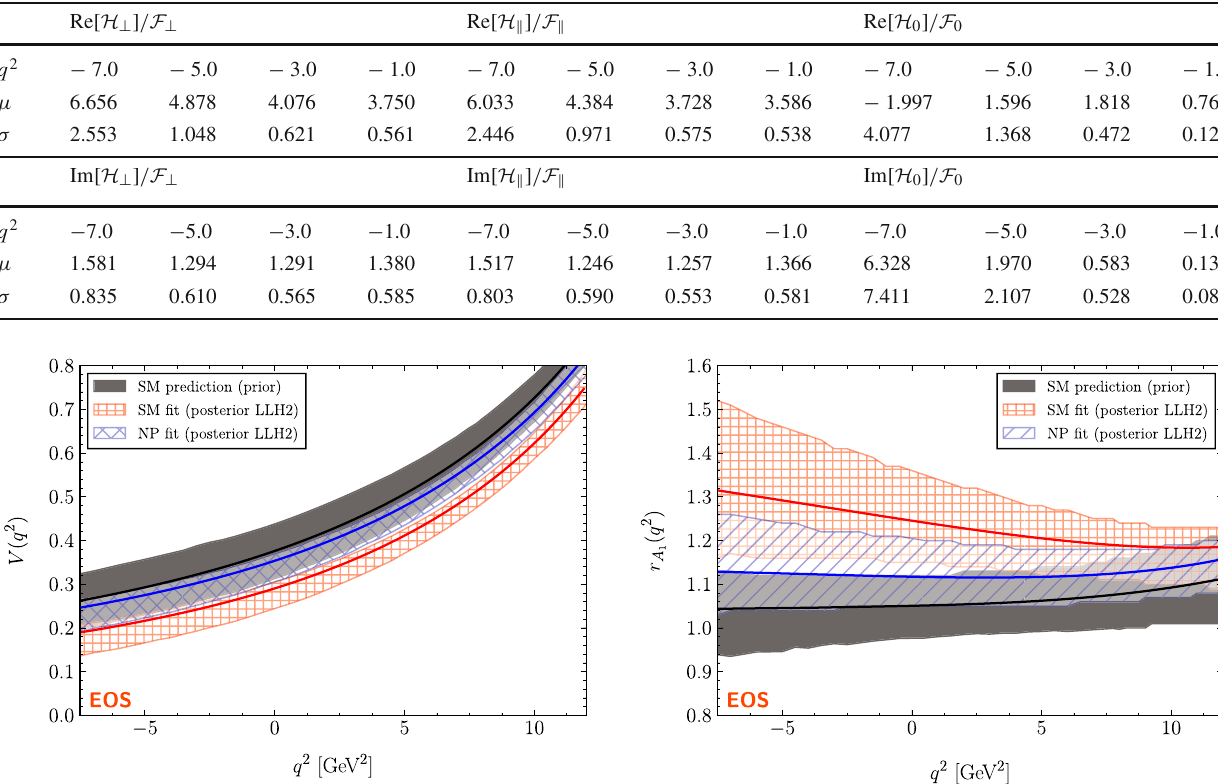
Fig. 4 A-priori predictions of the form factor V and the symmetry ratio r A